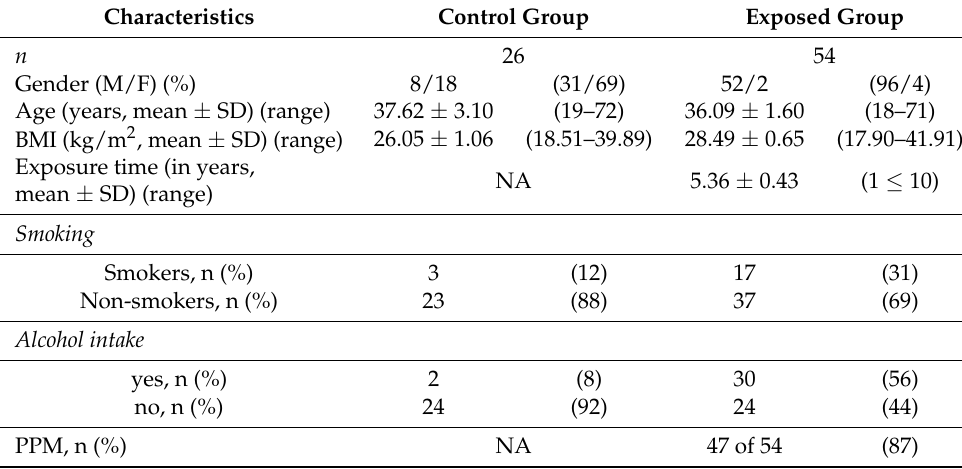
Table 1. Characteristics of the control and the exposed